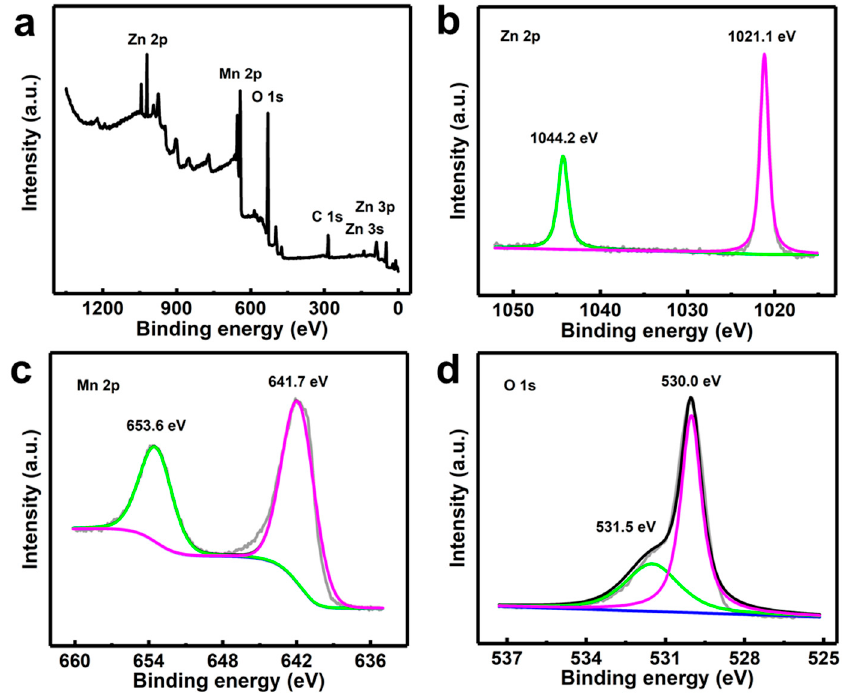
Figure 3. ( a ) XPS survey and high-resolution ( b ) Zn 2p, ( c ) Mn 2p, and ( d ) O 1s spectra of the ZMO HMRs.